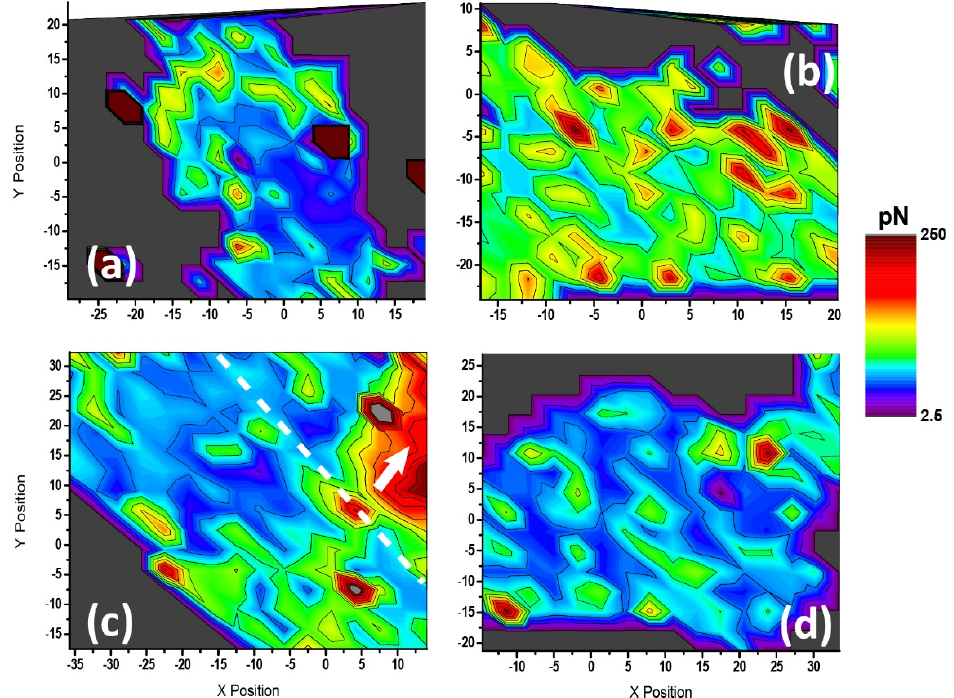
Figure 7. Cell mapping on adhesion force variation resulting from P2X7R stimulation of rat cerebellar astrocytes. ( a ) Control (untreated), ( b ) BzATP, ( c ) A43, and ( d ) A43/BzATP. The thick dashed line in ( c ) delimits two neighboring astrocytes. The inner thin line and the arrow point at the area occupied by the body region of such an attached cell. The color scale bar ranges in all cases between 2.5 and 250 pN (piconewton). Out-of-range values are shown in dark grey (i.e., glass substrate).